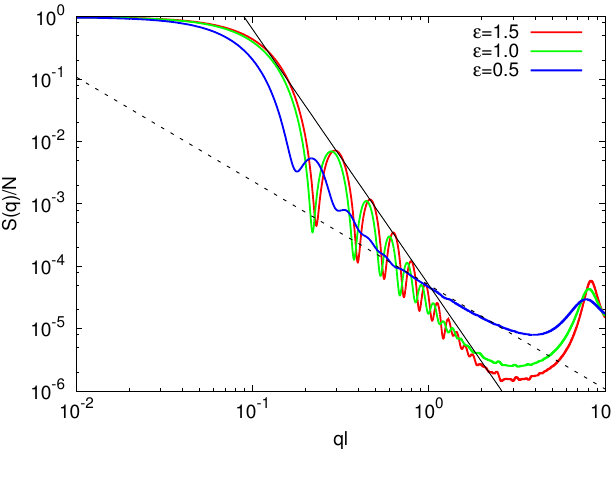
Figure 5. Spherically averaged static structure factors S ( q ) for N (cid:15)/ ( k T ) = 1 . 5 (red), 1 . 0 (green) and 0 . 5 (blue). The straight solid line is proportional to B q − 4 . 1 and the straight dashed line to q − 1 / 0 . 6